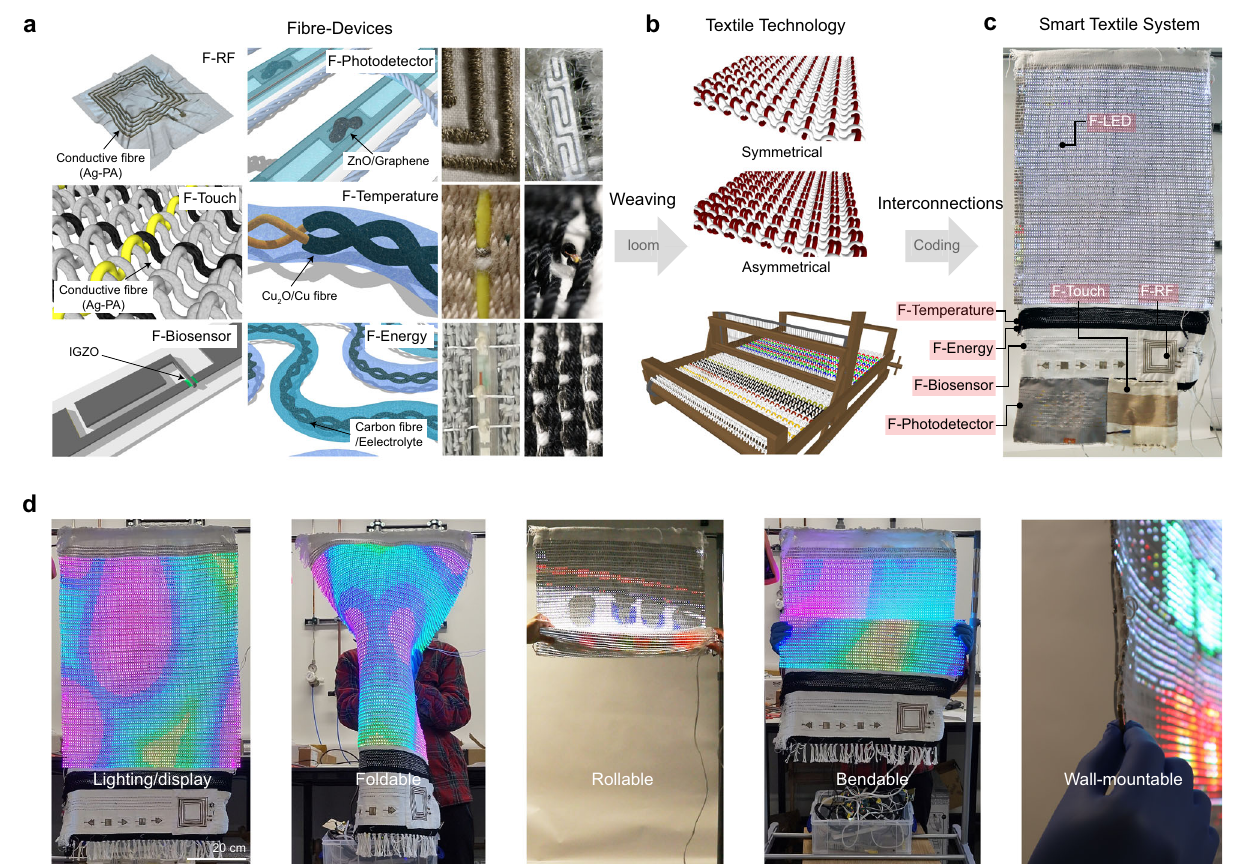
Fig. 1 The fabrication protocol and mechanical stability of smart textile system integrated with six F-devices and lighting/display apparatus (F-LED). Technology convergence between textile engineering and electronic science for smart textile display system fabrication; a Schematics of F-devices and corresponding fabricated F-devices. b Textile technology (weaving). c Smart textile system. d Mechanical stability of smart textile display system under folding, bending, rolling conditions and side view of the wall-mountable